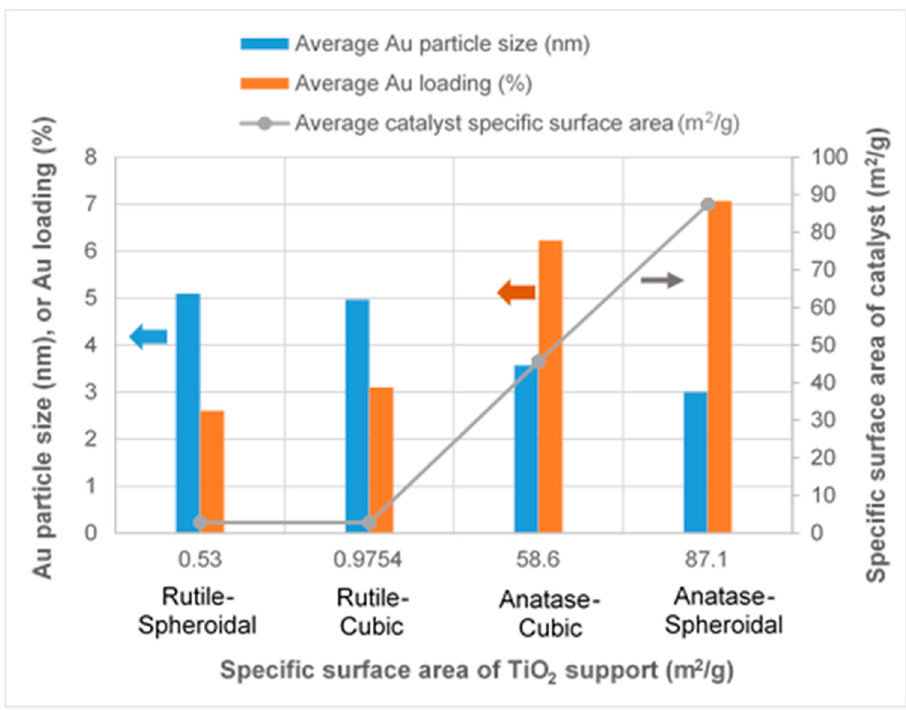
Figure 5. Effects of different TiO 2 supports on Au particle size, Au loading and catalyst specific surface area. Table 1. Au loading, Au particle size, X-ray photoelectron spectroscopy (XPS) analysis of Au 0 and Au 3+ , Brunauer–Emmett–Teller (BET) and diffuse reflectance infrared Fourier transform spectroscopy (DRIFTS) results.